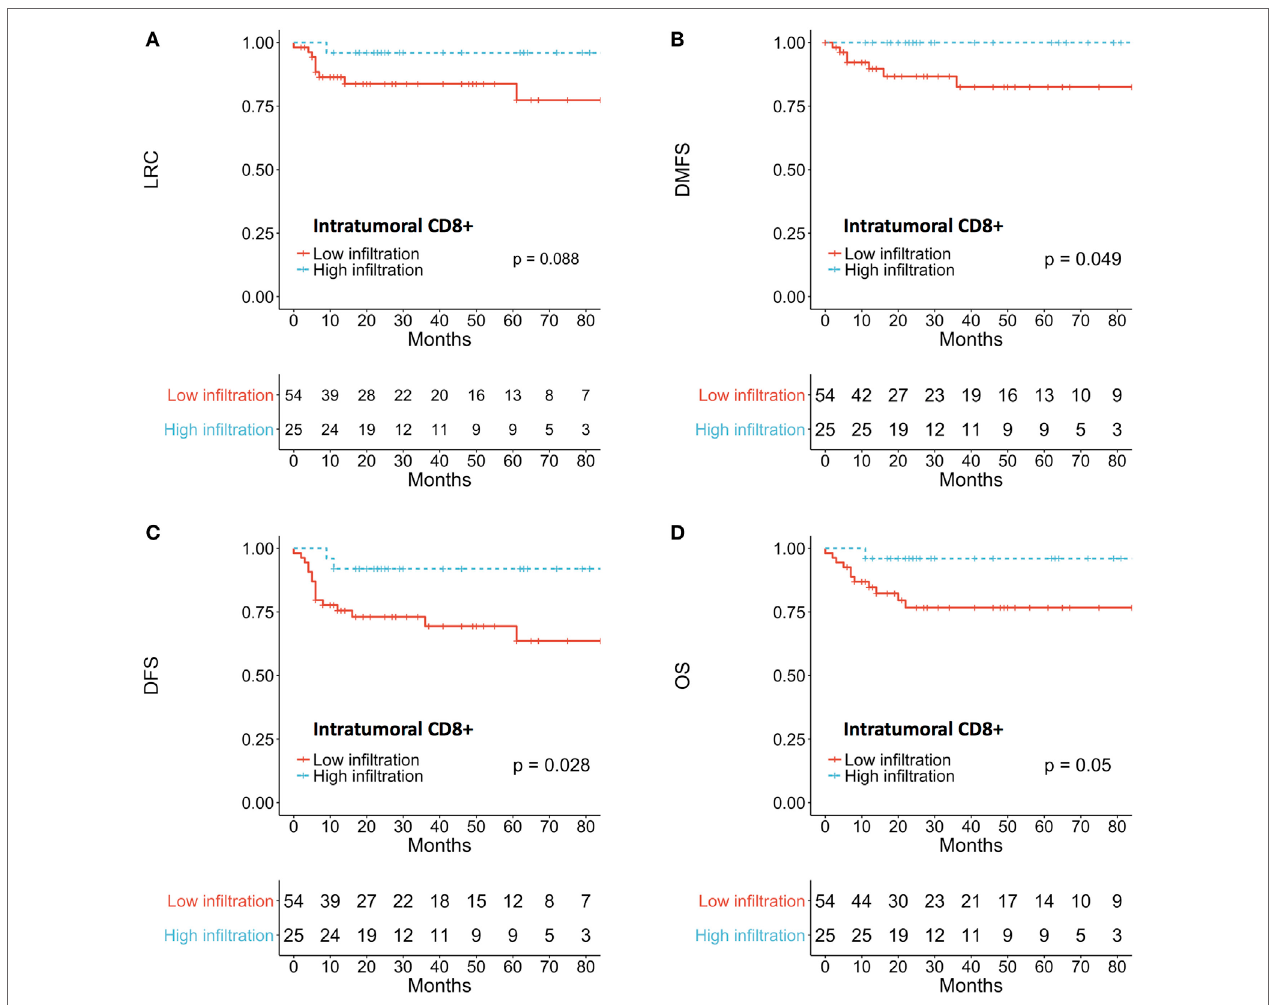
FigUre 4 | Prognostic impact of intratumoral CD8 + T-cells on (a) LRC, (b) DMFS, (c) DFS, (D) OS. Patients were dichotomized according to the median intratumoral score. LRC, locoregional control; DMFS, distant-metastasis-free survival; DFS, disease-free survival; OS, overall